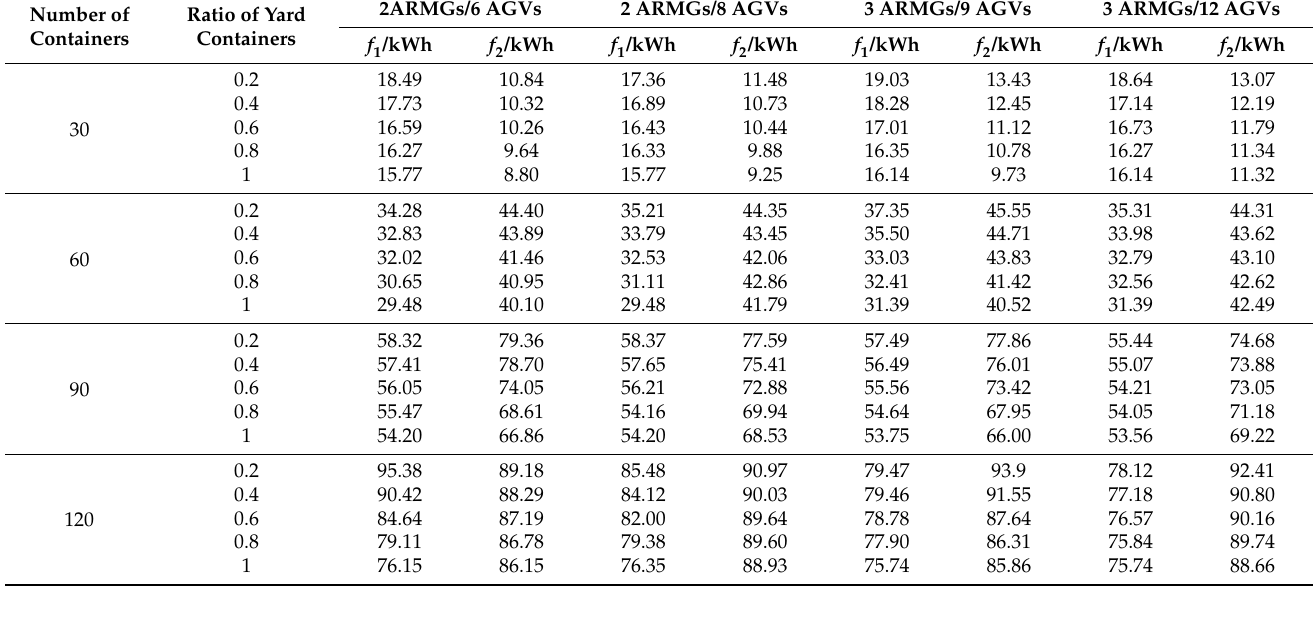
Table 7. Energy consumption for different containers with different yard containers ratios.